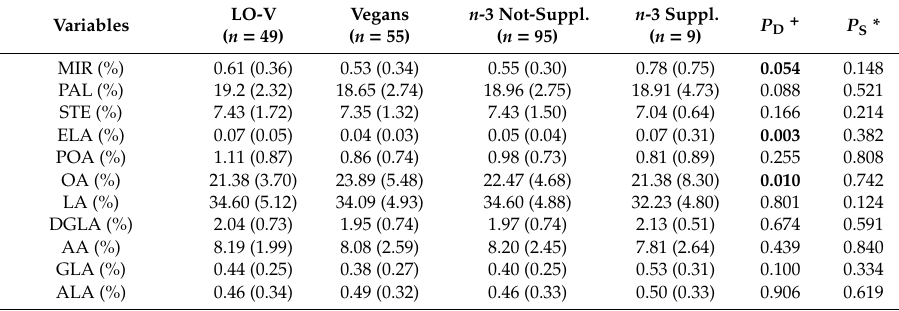
Table 3. Fatty acid profiles according to vegetarian diet type and use of n -3 supplements.